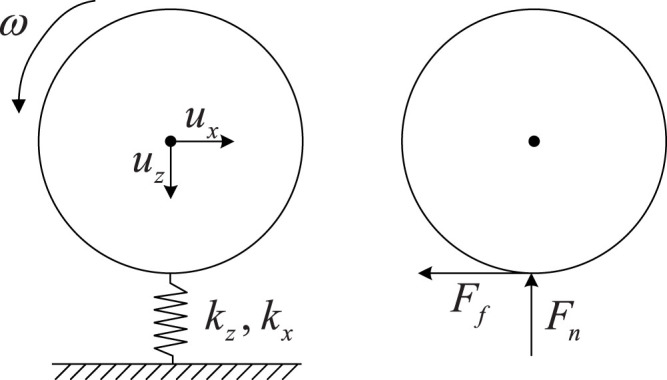
Simplified contact model with a constant contact stiffness (left) and the force diagram during the impact (right).